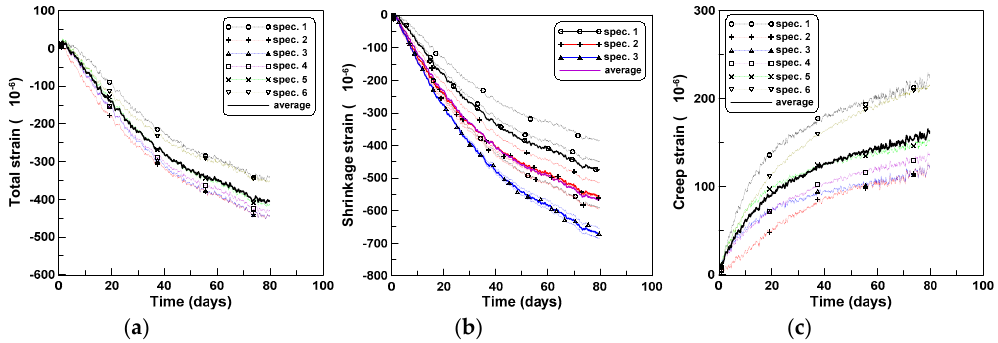
Figure 5. Tension creep tests of test series TP-3: ( a ) total strain, ( b ) shrinkage strain, and ( c ) creep strain.